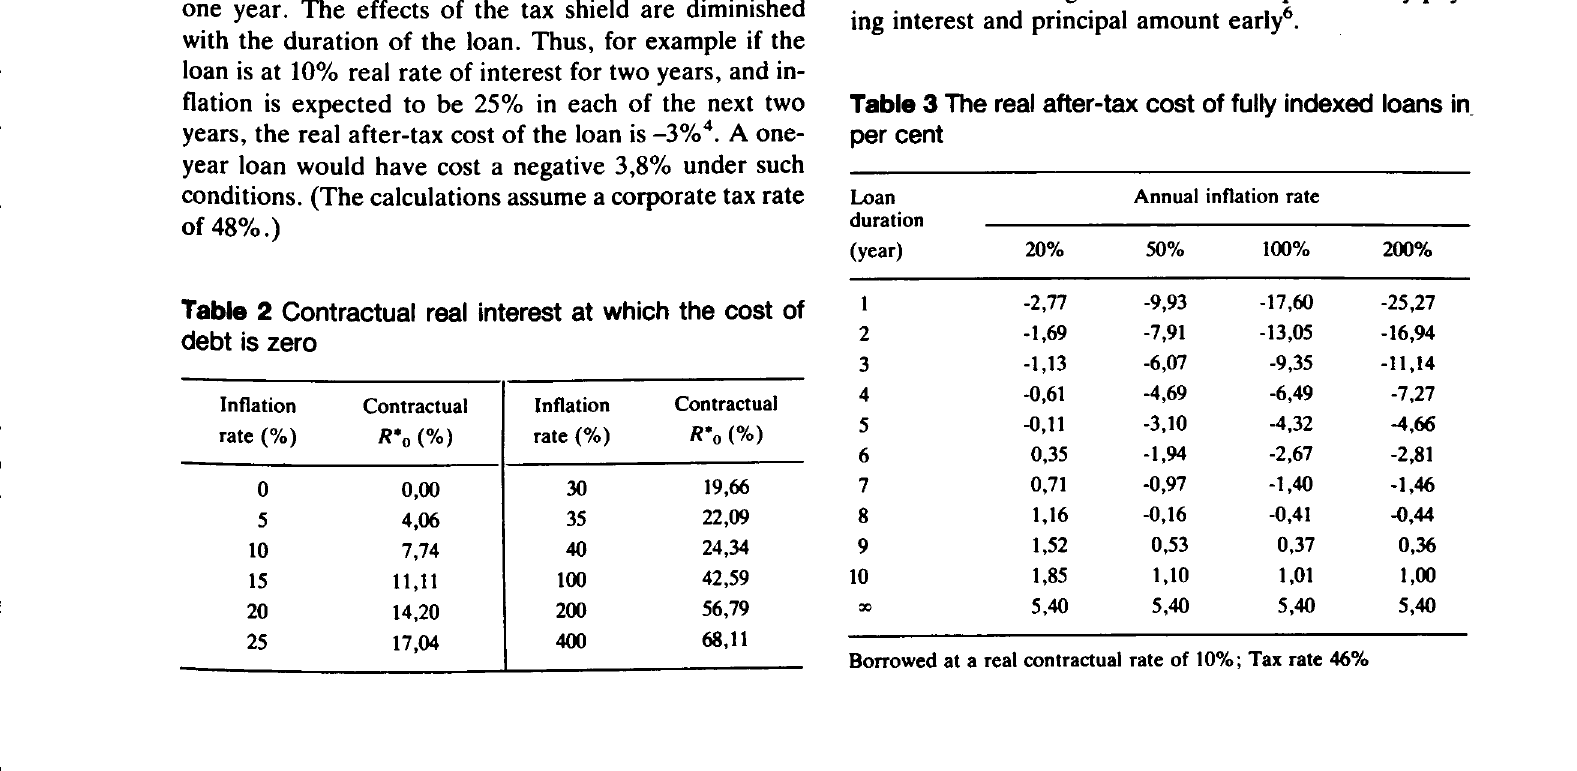
The real after-tax cost of debt can be derived by sol ving equation (8) for R*